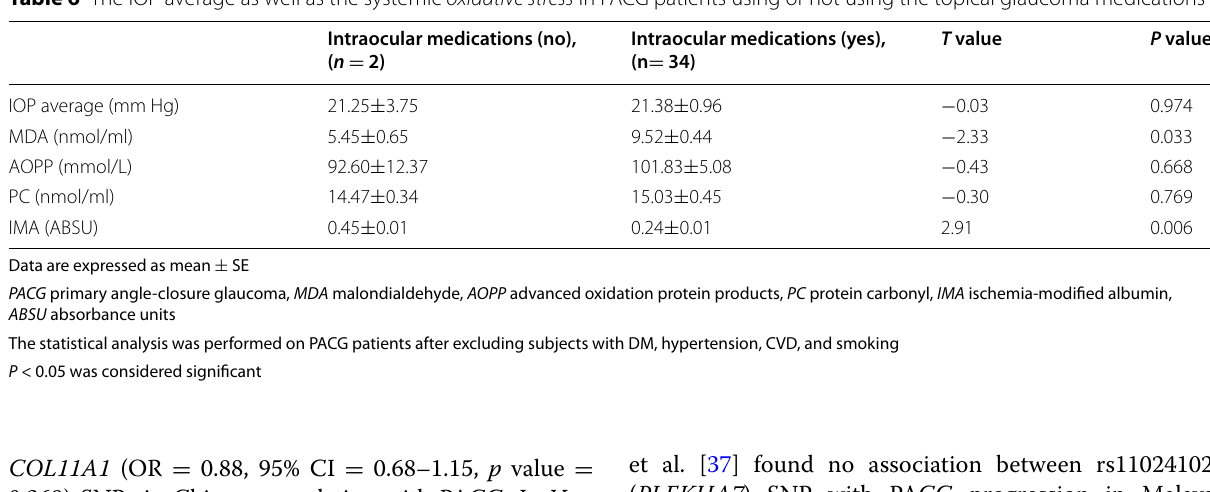
Table 6 The IOP average as well as the systemic oxidative stress in PACG patients using or not using the topical glaucoma medications